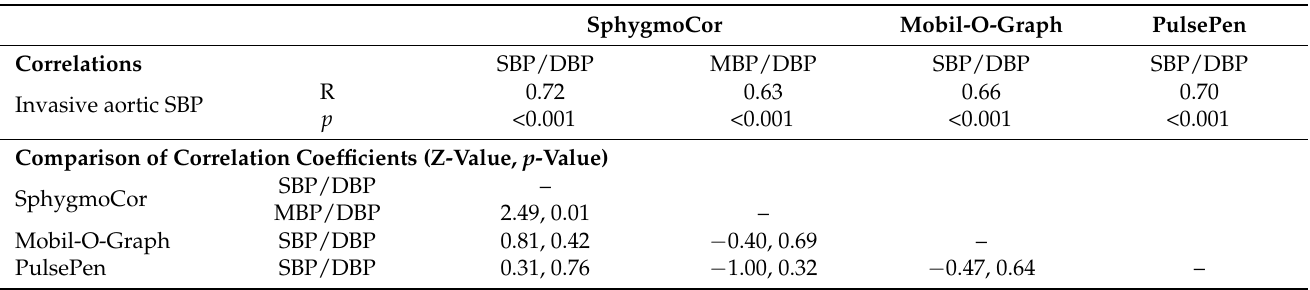
Table 3. Correlations between noninvasive and invasive central SBP and comparison among correla- tion